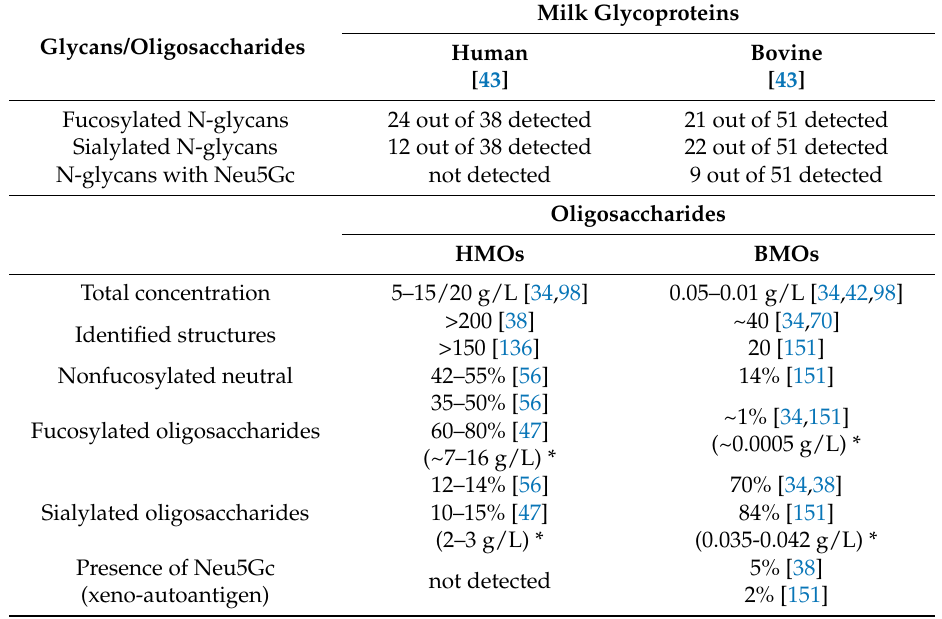
Table 2. Comparison of human and bovine milk glycoproteins and free oligosaccharides.